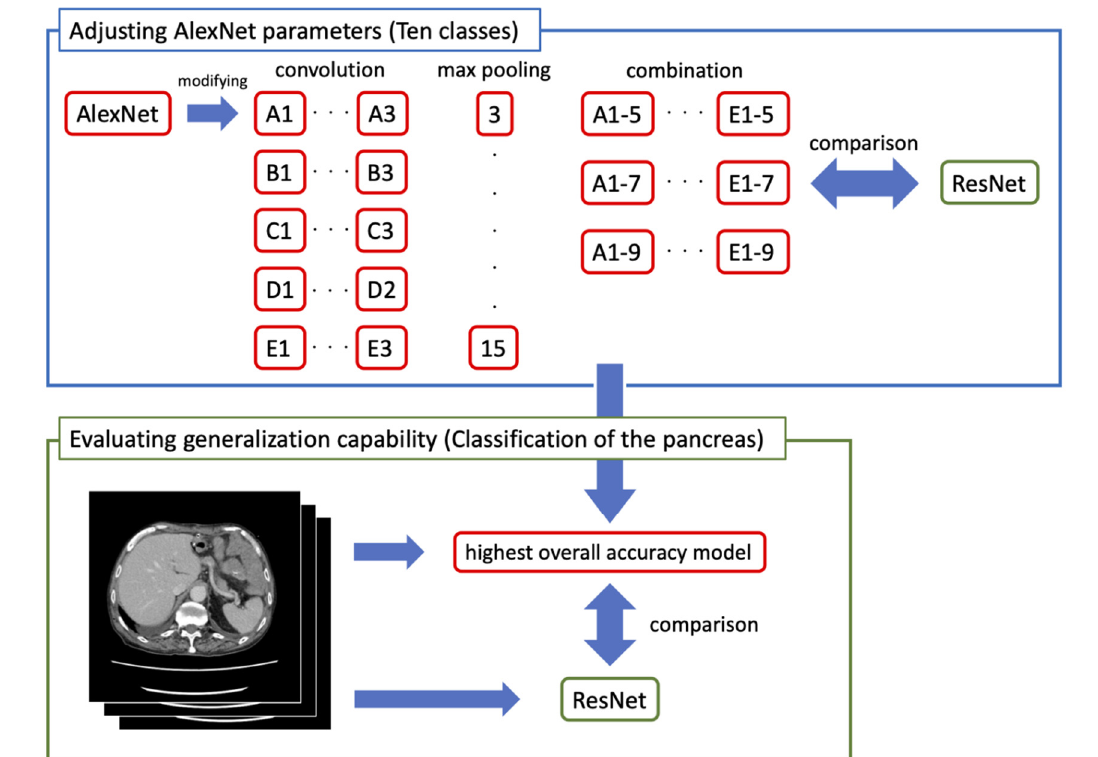
Figure 3. The entire learning and evaluation process.